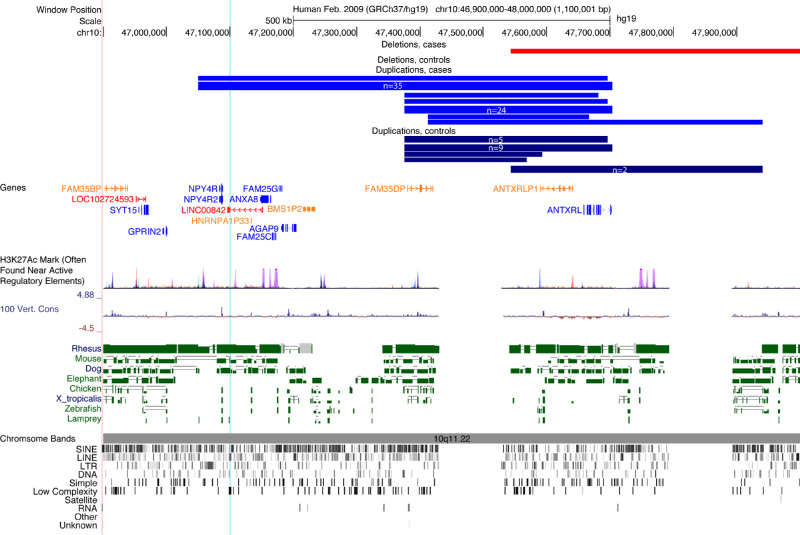
Chromosome 10 duplication significantly enriched in esotropia cases. UCSC genome browser plot showing the region of duplication on 10q11.22 (10:47049547-47703870). Duplications across the full 700kb were present in 36 cases (light blue, n indicates number with each set of breakpoints). A smaller, ∼300-kb duplication was present in 28 additional cases and 18 controls (dark blue). A nearby deletion was present in one case (red). RefSeq genes are listed underneath. Protein coding genes are in blue, long noncoding RNA genes are in red, and noncoding RNAs are in orange. H3K27Ac mark indicates several putative regulatory regions fall within the duplication. This area is not well conserved over 100 vertebrates. There is some conservation with monkey, but very little with other animals. The blue vertical line indicates the position of the ddPCR probe used to confirm the duplication. The gap in the annotations indicates an unmappable area of the reference genome, usually because it is highly repetitive or of low complexity. At bottom are indicated repeats in the region identified by RepeatMasker: SINE, short interspersed nuclear elements; LINE, long interspersed nuclear elements; LTR, long terminal repeat elements; DNA, DNA repeat elements; SIMPLE, microsatellites, low complexity repeats, satellite repeats, RNA repeats, and other repeats.